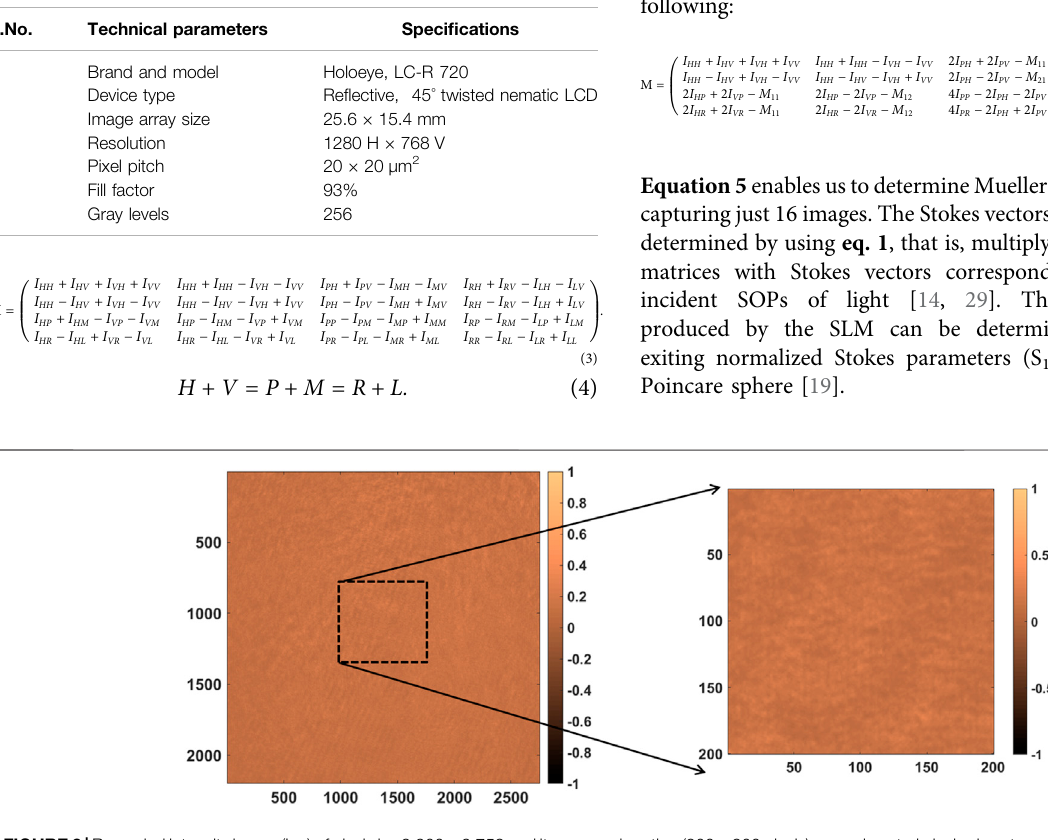
FIGURE2| Recordedintensityimage(I HH )ofpixelsize2,200 × 2,752anditscroppedportion(200 × 200pixels)aroundcentralpixelvalueatgrayvalue255ofSLM display.